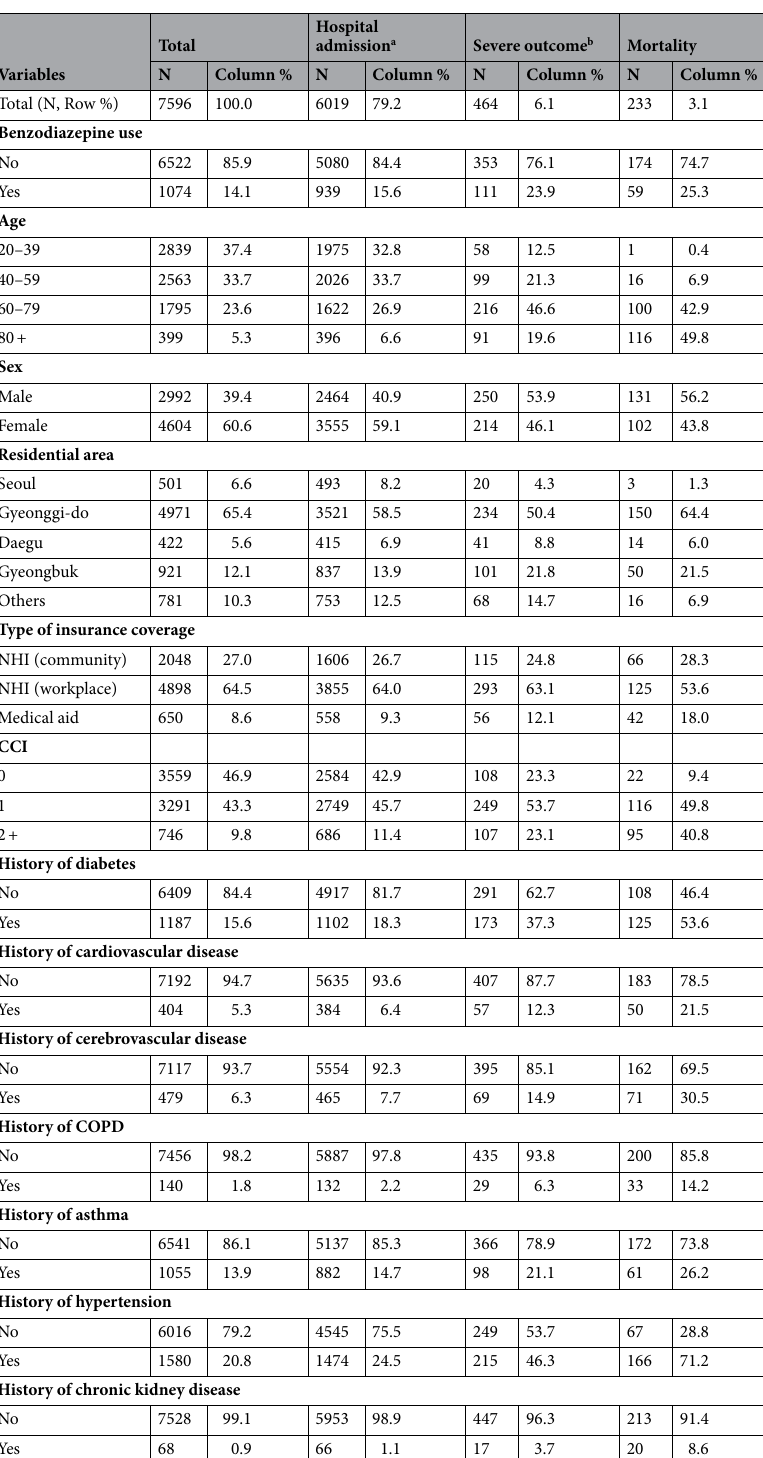
Table 3. General characteristics of the patients who tested positive for severe acute respiratory syndrome coronavirus 2 (SARS-CoV-2). NHI National health insurance, CCI Charlson Comorbidity Index, COPD chronic obstructive pulmonary disease, ICU intensive care unit. a Hospital admission comprised admission, admission to the intensive care unit, invasive ventilation, or mortality. b Severe outcome comprised admission to the intensive care unit or invasive